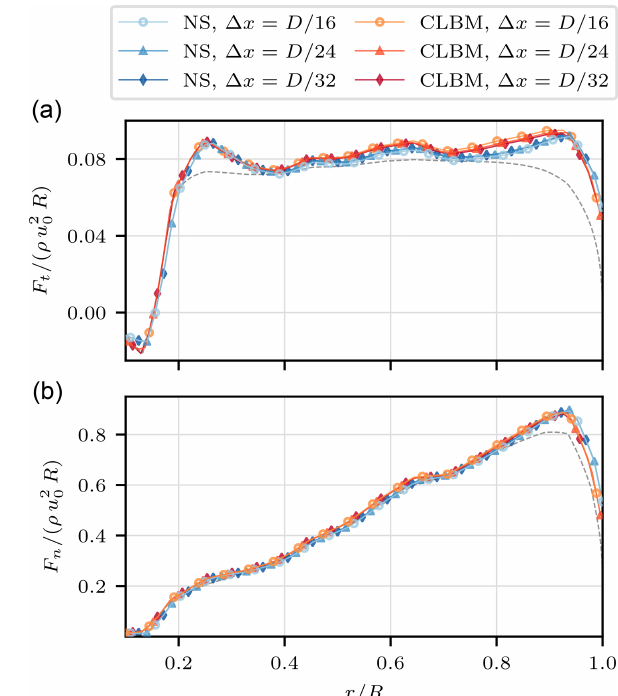
Figure 4. Mean tangential force F t (a) and normal force F n (b) along the actuator line. For the sake of visibility, markers are only shown for every third data point. The grey dashed line marks the BEM reference by Hansen